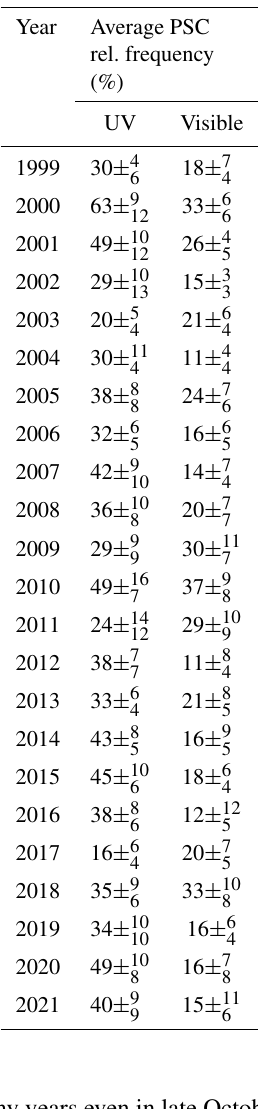
Table 1. The average PSC relative frequency in % above the Neu- mayer station for each winter season from May to November. Data are given for both spectrometers as